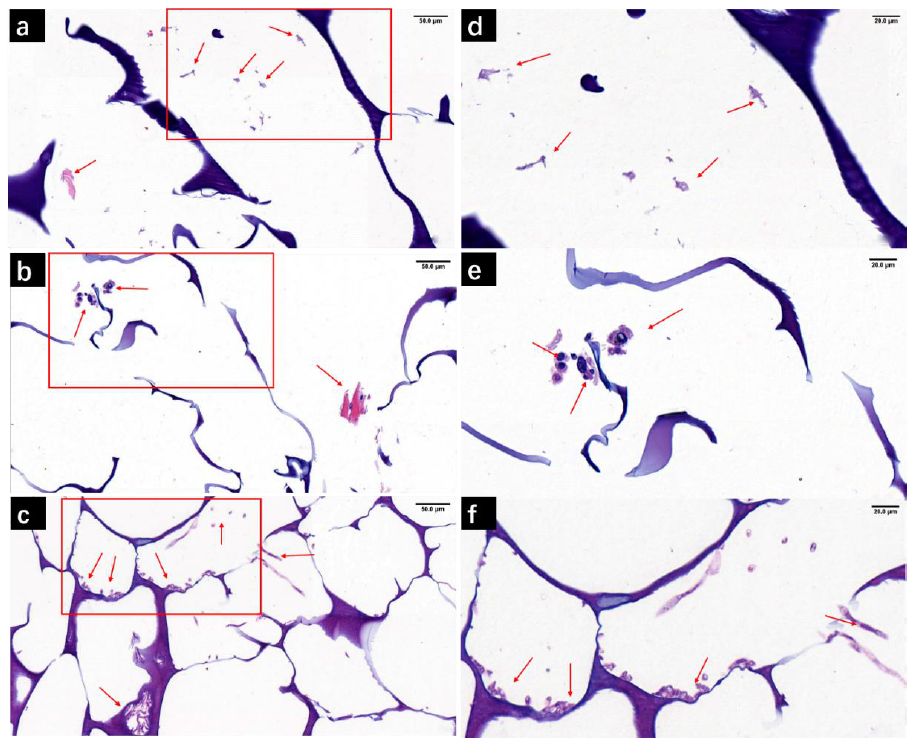
Figure 6. H&E staining showed the distribution of DPCs seeded on the scaffolds for 3-day in vitro culture. ( a ) FCC, ( b ) AC, and ( c ) FA. ( d – f ) Corresponding to the partial enlarged diagrams of a – c. The arrows point mostly to the area where and ( c ) FA. ( d – f ) Corresponding to the partial enlarged diagrams of ( a – c ). The arrows point mostly to the area where the the cells aggregated. Scale bars, (a- c) = 50 μm, (d - f) = 20 μm. cells aggregated. Scale bars, ( a – c ) = 50 µ m, ( d – f ) = 20 µ